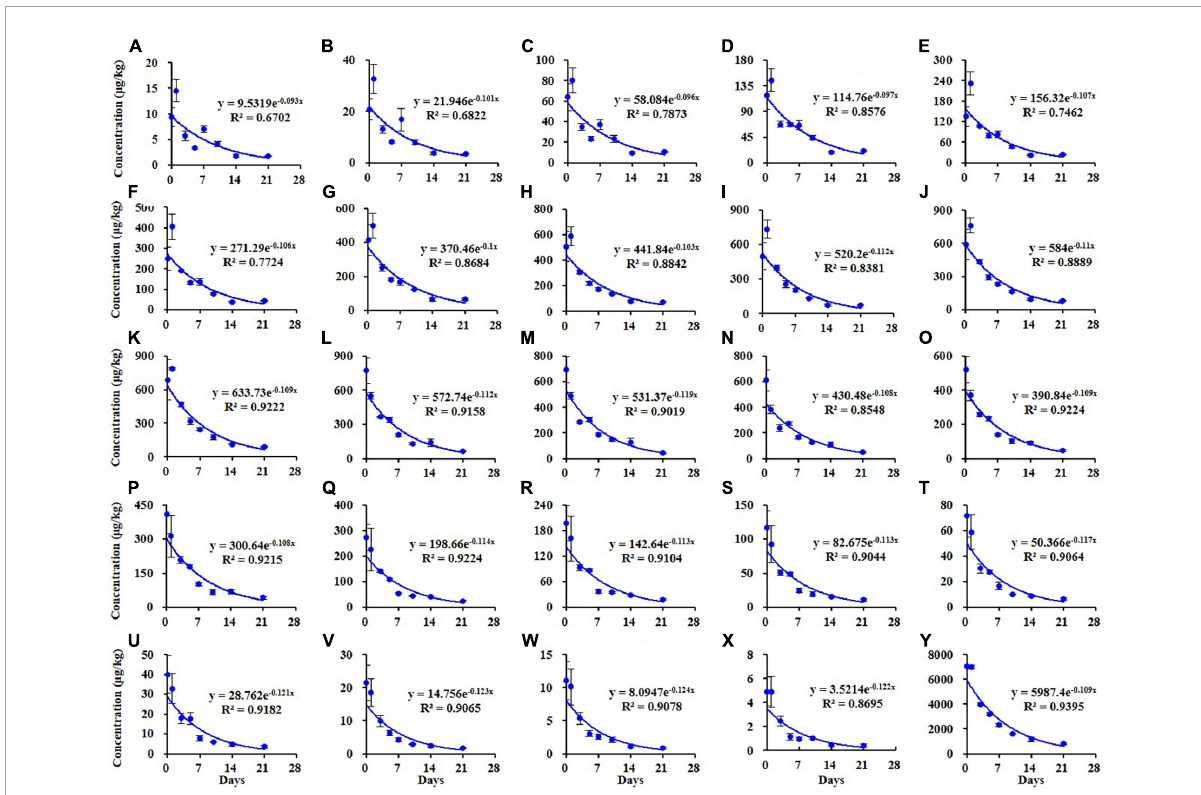
FIGURE3 Dissipation kinetics curves of different tristyrylphenol ethoxylates (TSPEOn) [ n = 6–29, (A–X) ] homologs and (cid:54) TSPEOn (Y) in soil in China.